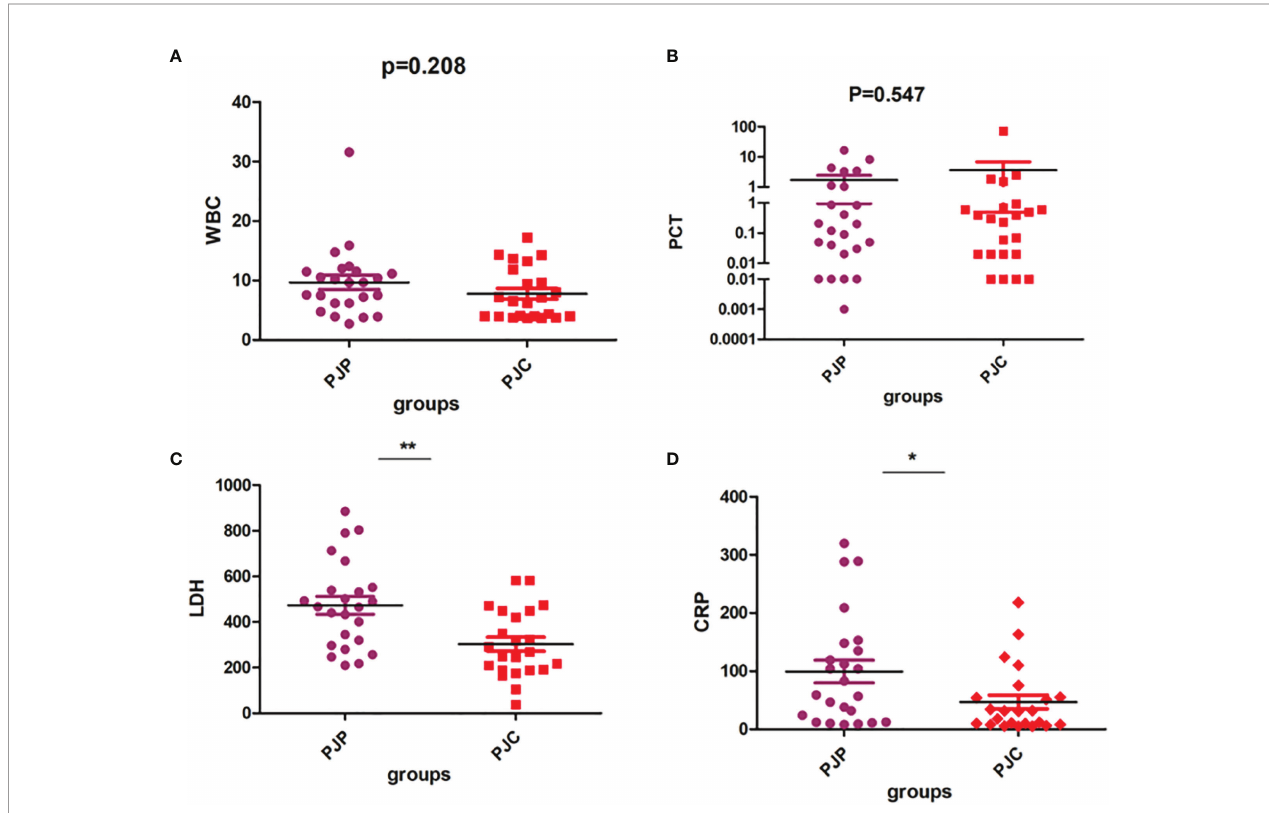
FIGURE 5 | Test of white blood cell (WBC), procalcitonin (PCT), lactate dehydrogenase (LDH), and C-reactive protein (CRP) between the Pneumocystis jirovecii pneumonia (PJP) and Pneumocystis jirovecii colonisation (PJC) groups. (A) Test of WBC between the PJP and PJC groups. (B) Test of PCT between the PJP and PJC groups. (C) Test of LDH between the PJP and PJC groups. (D) Test of CRP between the PJP and PJC groups. **P = 0.001; *P =